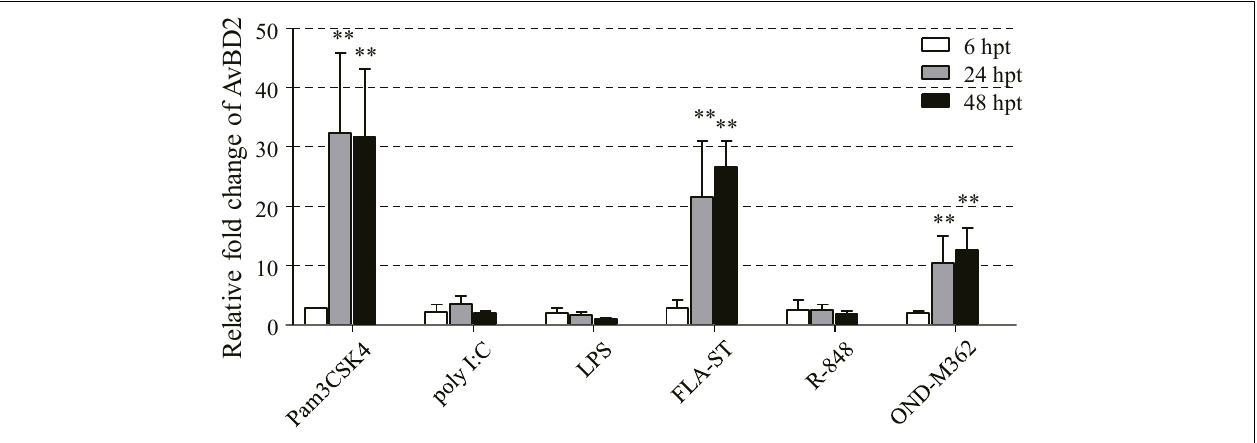
FIGURE 5 | Induction of AvBD2 mRNA expression following TLR ligands stimulation in CEFs. CEFs were treated with Pam3CSK4 (0.4 µ g/ml), polyI:C (50 µ g/ml), LPS (2 µ g/ml), FLA-ST (2 µ g/ml), R848 (5 µ g/ml), and ODN-M362 (2.5 µ M), respectively. CEFs in the control groups received medium. Fold change of mRNA expression in CEFs of each group were measured at 6, 24, and 48 h post-treatment using RT-PCR. Transcript levels of AvBD2 were normalized to 18s rRNA and mRNA expression is presented as the fold change relative to the control group. All assays were performed in triplicate, and each bar is the mean ± SEM. Statistical significant difference between cells without and with TLR ligands are indicated by ∗ p < 0.05 or ∗∗ p < 0.01.